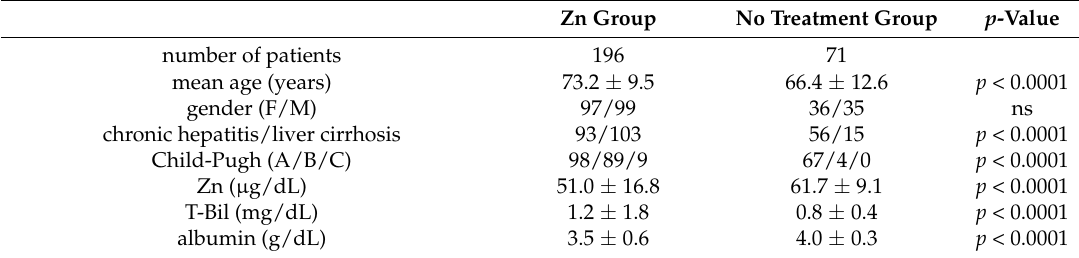
Table 1. Clinical profiles of 267 patients with chronic liver diseases enrolled in this study.